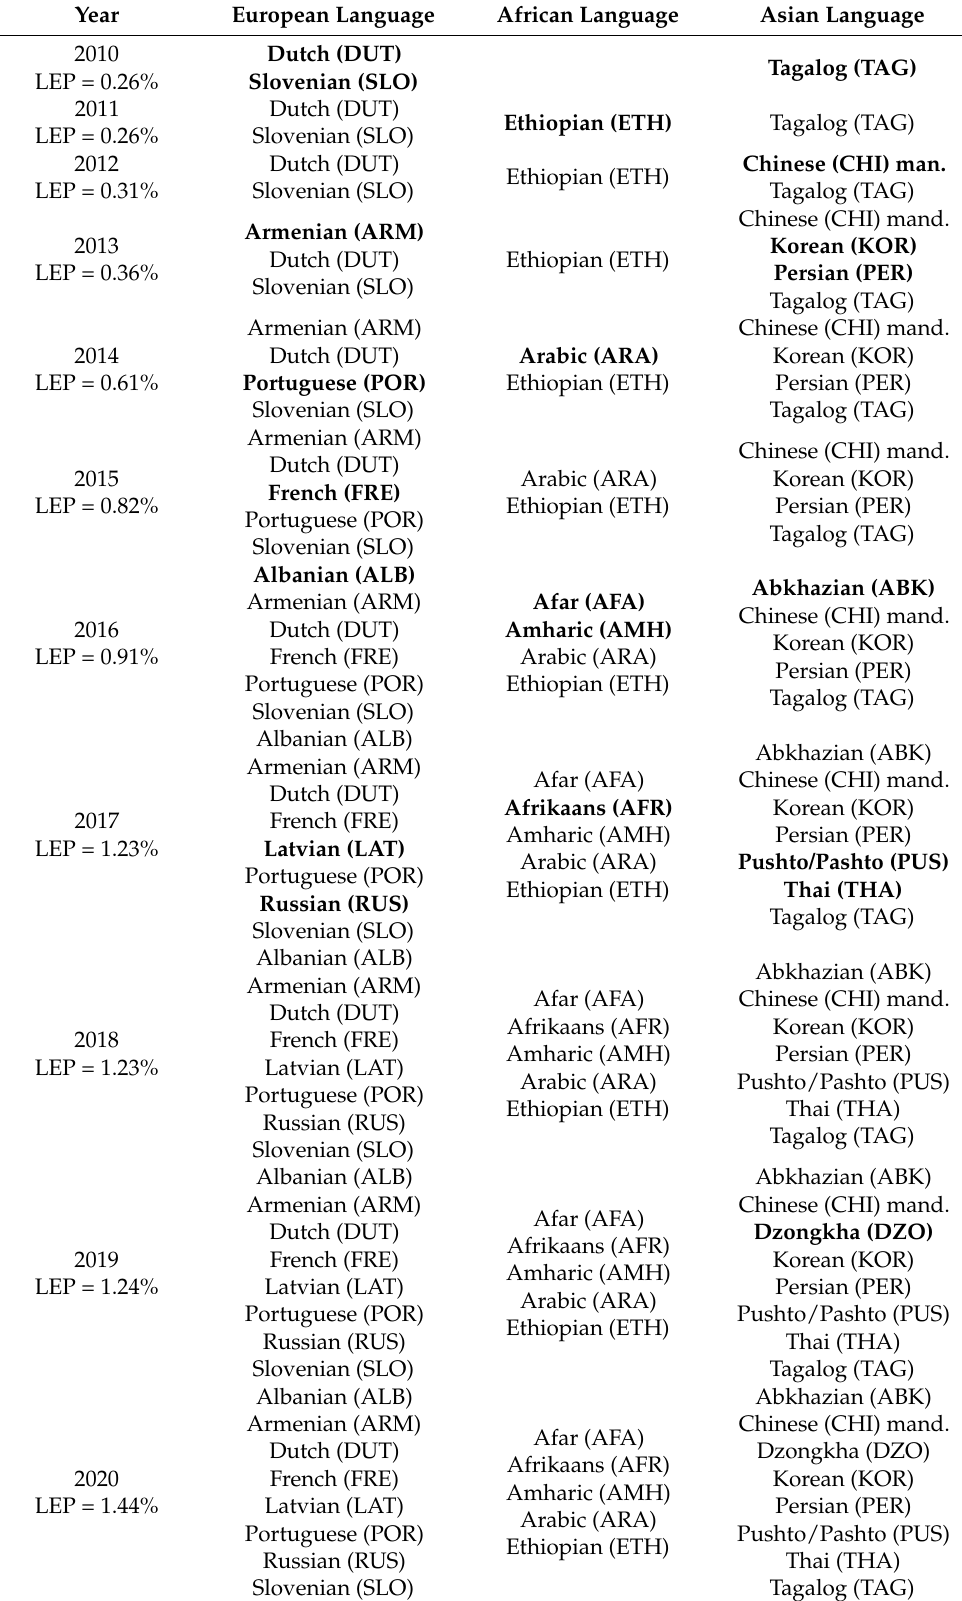
Table 2. Preferred languages spoken (not English or